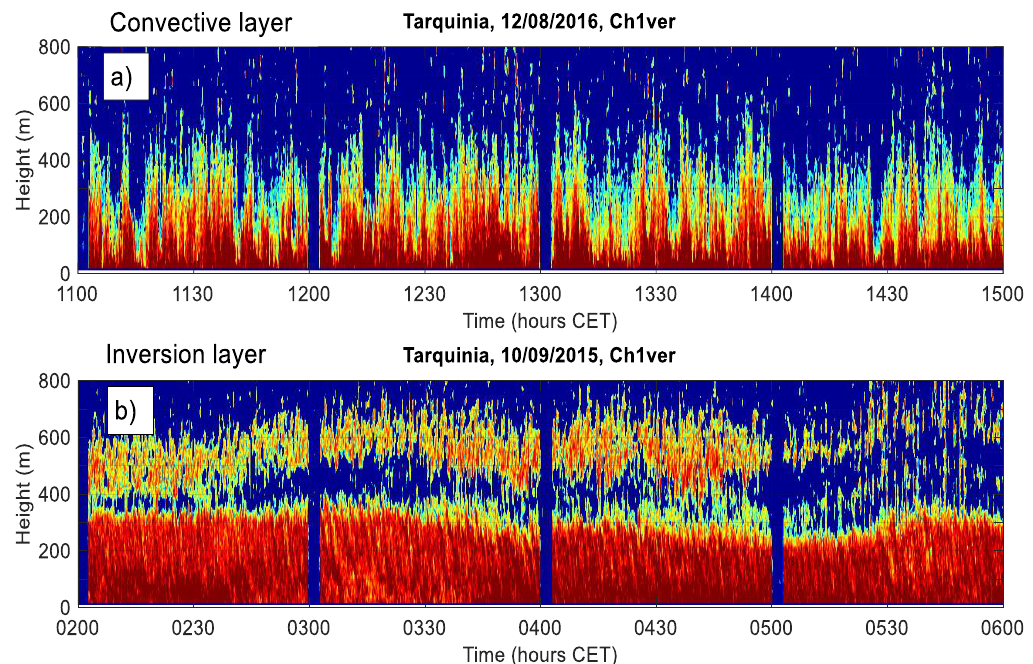
Figure 14. Examples of typical sodar echograms indicating ( a ) a convective layer and ( b ) a temperature inversion layer.